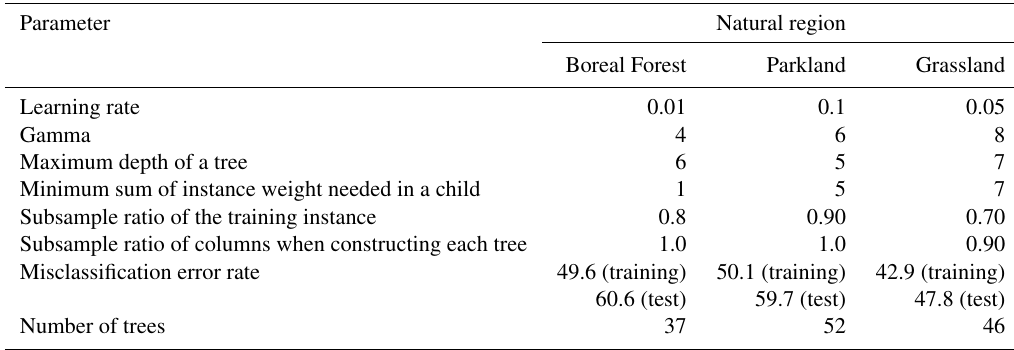
Table D1. Value of parameters used in extreme gradient boosting models for our three datasets, the misclassification error rates and number of trees for our models.